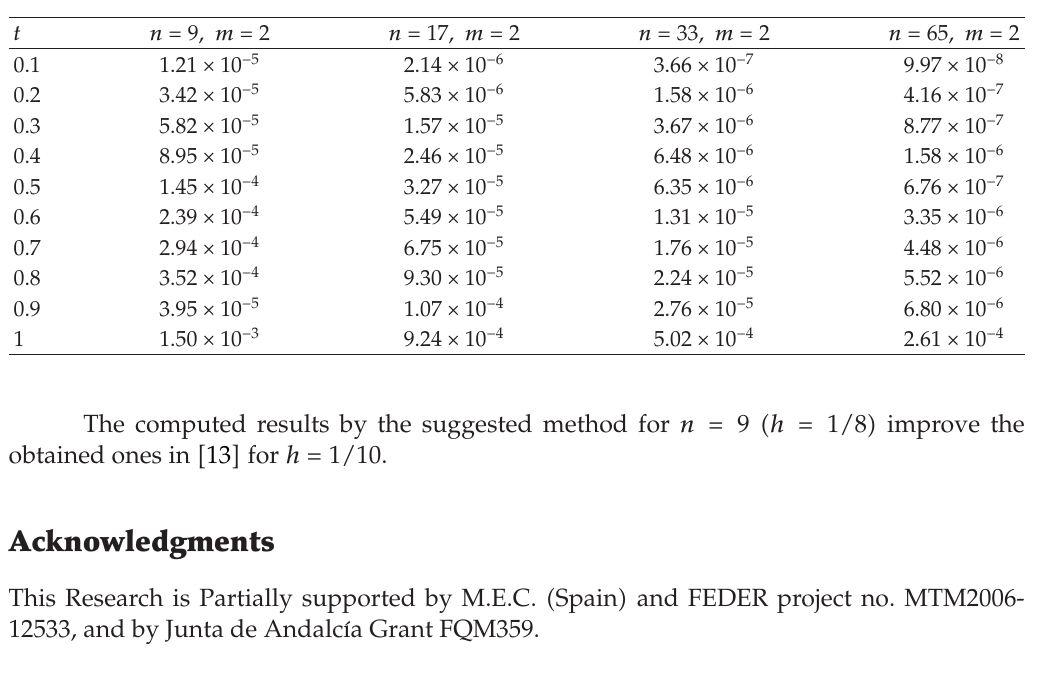
Table 3: Numerical results for Example